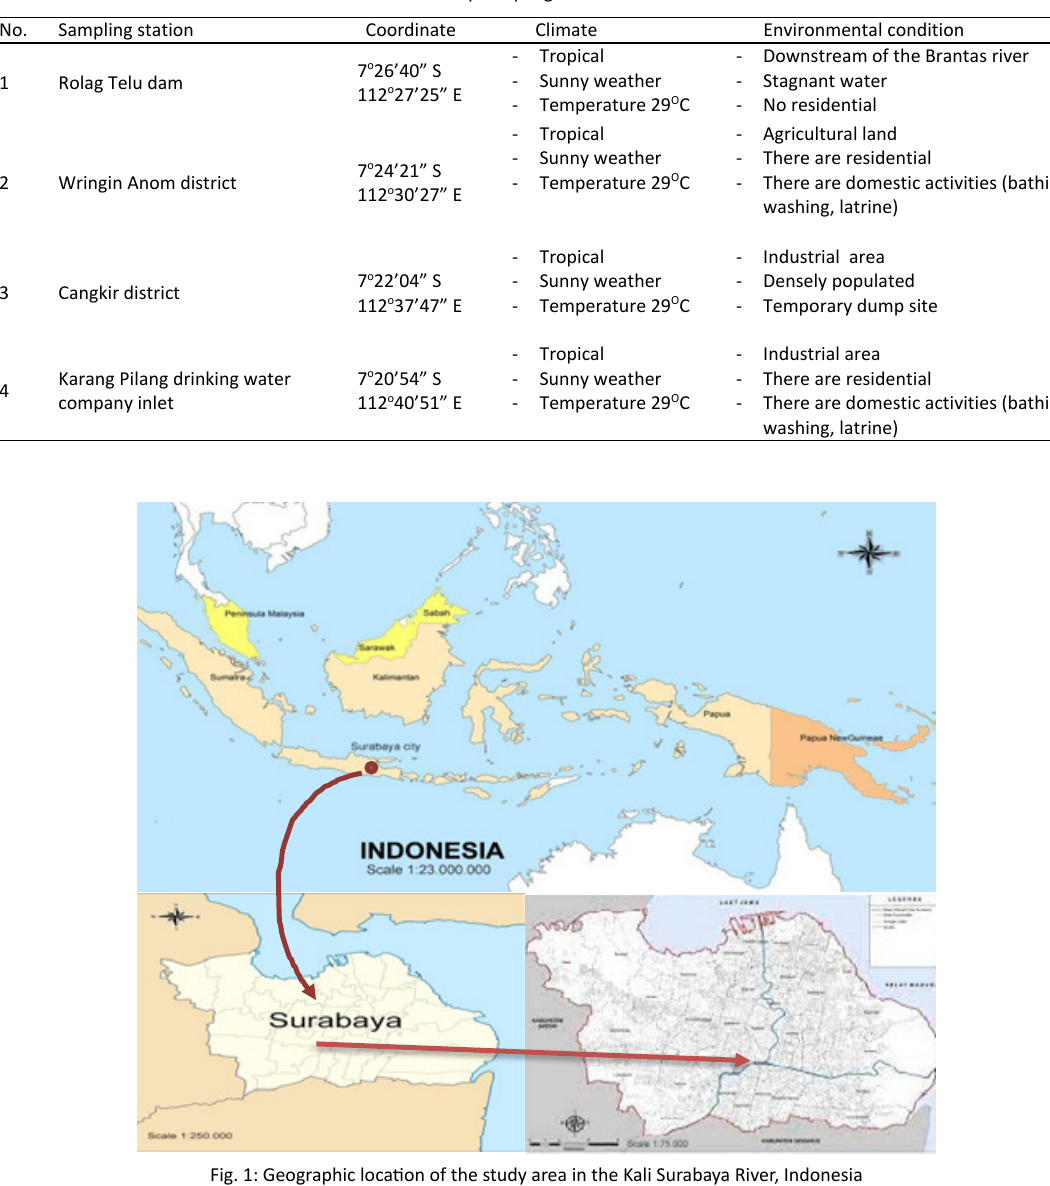
Table 1: The study sampling location characteristics